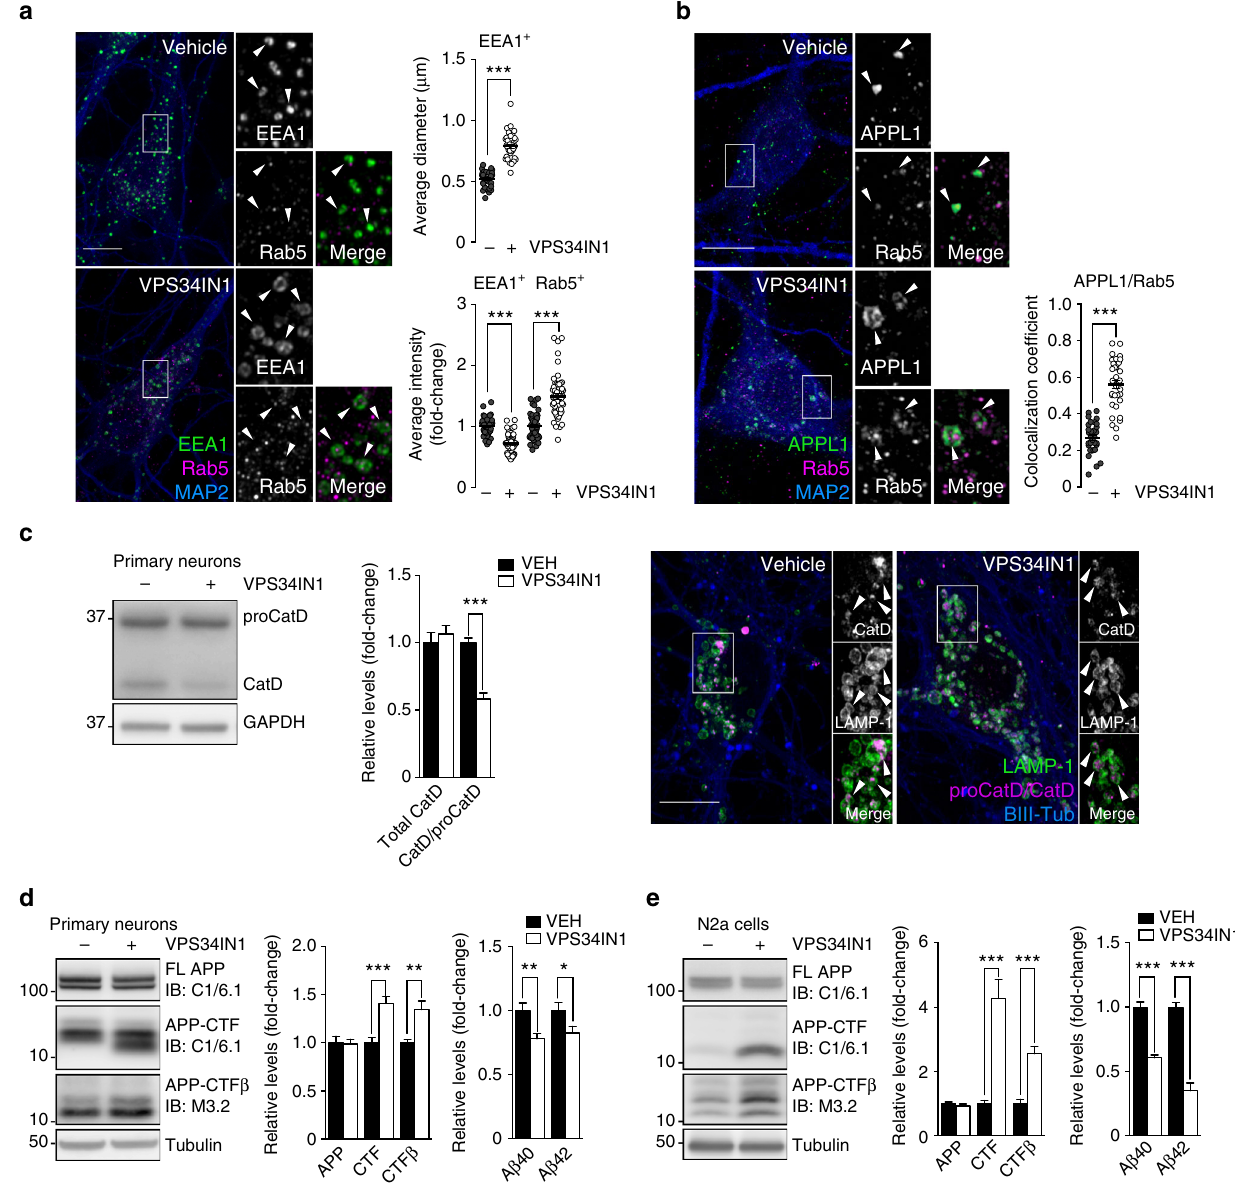
Fig. 1 Vps34 inhibition induces early endosomal abnormalities and causes accumulation of APP-CTFs. a , b Representative confocal images of cultured cortical neurons treated with vehicle or VPS34IN1 at 3 µ M for 3 h. a Super-resolution Airyscan insets and arrows highlight EEA1 endosomes. Bar graphs indicate average EEA1-puncta size, per cell (mean ± SEM, N = 37 and 44 cells, respectively, from three independent experiments) and average EEA1/Rab5 puncta intensity, per cell (mean ± SEM, N = 55 and 63 for vehicle and VPS34IN1, respectively). b Airyscan insets highlight colocalization between APPL1 and Rab5. Bar graph indicates fraction of APPL1 signal colocalizing with Rab5 (mean ± SEM, N = 35 cells, from three independent experiments). Scale bar, 10 µ m. *** p < 0.001 in two-tailed Student ’ s t test. c Western blot analysis of Cathepsin D levels in primary cortical neurons treated with vehicle or VPS34IN1 at 3 µ M for 24 h. Bar graph represents average protein levels of total CatD (sum of CatD and proCatD) or ratio of CatD/proCatD, normalized to vehicle (mean ± SEM, N = 7, from two independent experiments). Right panel, representative confocal images of primary cortical neurons. Airyscan insets highlight luminal sorting of Cathepsin D in LAMP-1-positive compartments. Scale bar, 10 µ m. *** p < 0.001 in two-tailed Student ’ s t test. d , e Western blot analysis of APP metabolites from primary cortical neurons treated as in c or N2a cells treated with VPS34IN1 at 1 µ M for 24 h. Bar graph denotes average protein levels normalized to vehicle (mean ± SEM, N = 6 and 7, respectively, for primary neurons; N = 8 and 7, respectively, for N2a cells, from two independent experiments) and murine A β 40 and A β 42 levels measured by MSD from culture media (mean ± SEM, N = 12 and 13, respectively, for primary neurons; N = 8 and 7, respectively, for N2a cells, from two independent experiments). A β levels were normalized to lysate total protein. * p < 0.05, ** p < 0.01, *** p < 0.001 in two-tailed Student ’ s t